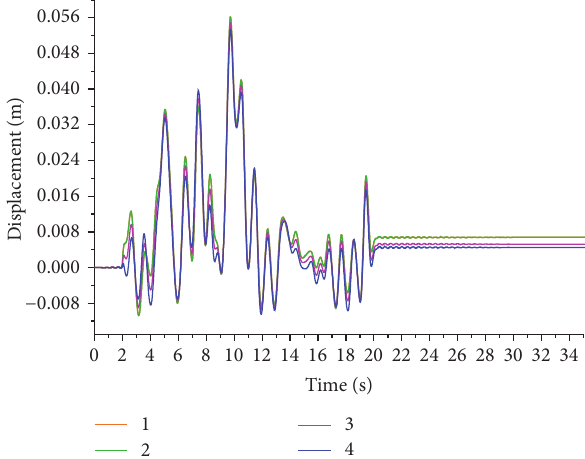
Figure 13: Displacement-time curve of monitoring points with supporting